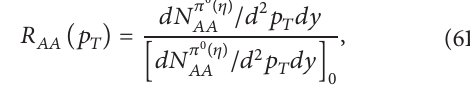
the fragmentation is not the same. We consider a jet initially produced at (𝑟, 𝜙) and leaves the plasma after a proper time ) or equivalently after traversing a distance 𝐿 (for light (𝑡 𝐿 quarks 𝑡 𝐿 = 𝐿 )